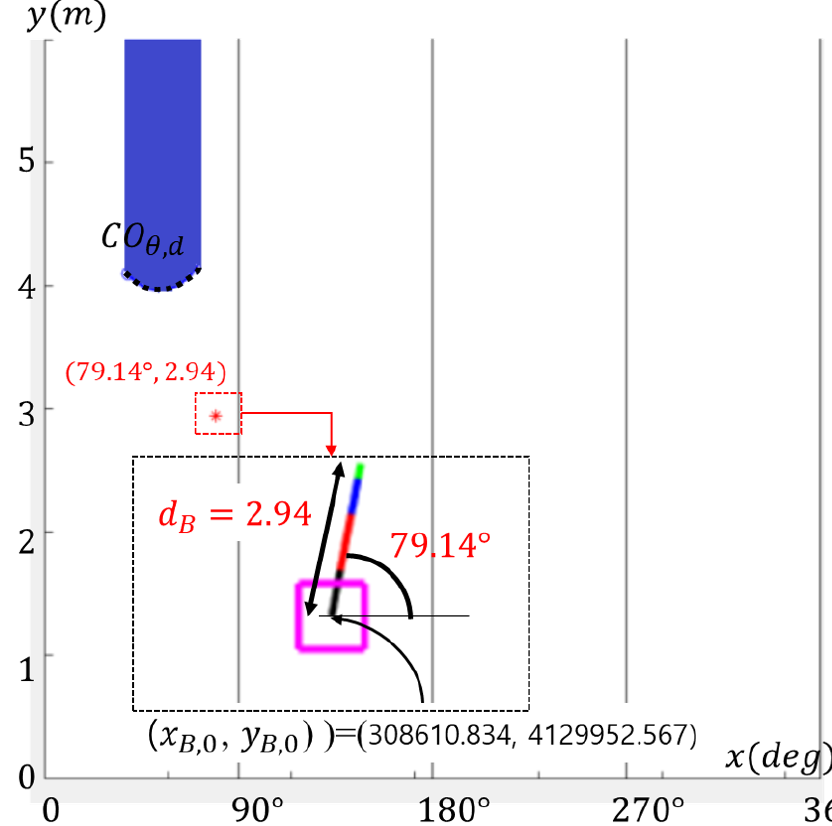
Figure 21. The experimental results of obstacle generation for guidance of the arm manipulation. Figure 22 shows two 50 by 1 matrices about CO i = j ( θ B ) and CO j ( d B ) from m and n chosen to be 50.